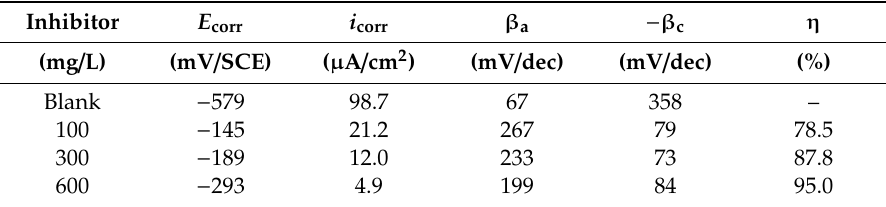
Figure 6. Potentiodynamic polarization curves in the absence and presence of different concentrations of GG-AMPS. Table 2. Electrochemical polarization parameters in the absence and presence of different concentrations of GG-AMPS at 308 K.